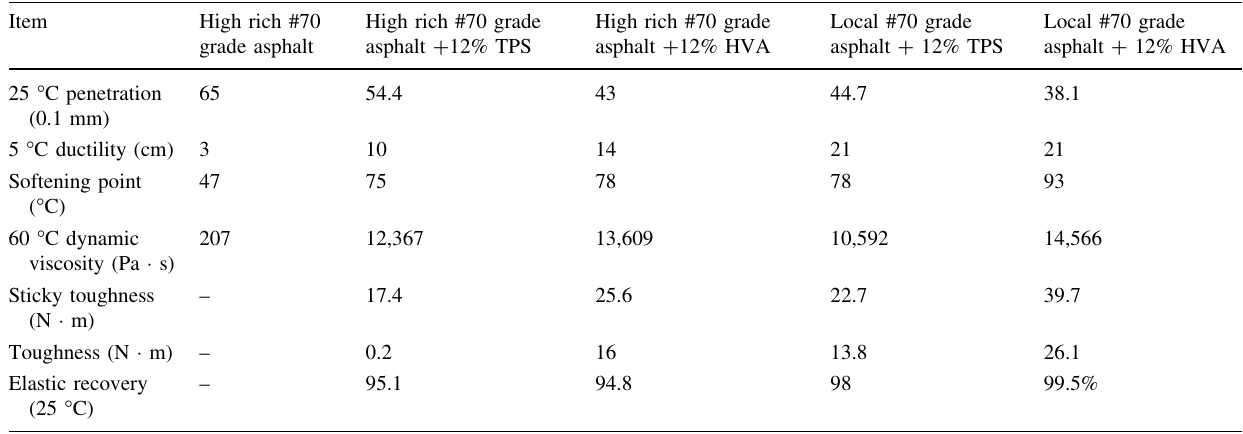
Table 8 Performance of different asphalt